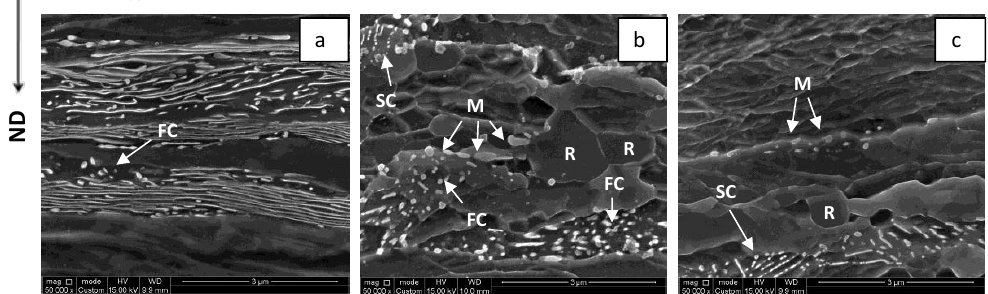
Figure 7. ( a ) SEM image of 70% cold-rolled material; ( b ) SEM of the sample heated at 150 °C/s to 704 °C and quenched and ( c ) SEM sample heated at 1500 °C/s to 749 °C and quenched (etched with 4% Nital). Letters in arrows are FC for fragmented cementite, M for martensite SC for spheroidized cementite, and R for recrystallized ferrite. The scale bar in three micrographs is 3 µm. The advancing of the α/α interface is also hindered by spheroidized cementite particles, as long as the distance between them is small enough to interact effectively with the interface movement [30,31]. Similar pinning effect can be produced by austenite grains (cf. M in Figure 7b,c). Evidence of this is clearly shown in Figures 1a,d and 7b,c. Small particles of cementite are blocking the advance of the recrystallized ferrite into pearlite, thus hindering the process at one side of the recrystallized grains. Otherwise, the recrystallization would progress into both deformed ferrite and pearlite as expected in the absence of growth barriers, such as low-angle grain boundaries with reduced mobility [31]. Instead, it has grown along ferrite bands and has stopped at cementite and pearlite areas. Note in Figure 6 that the boundary between recrystallized ferrite and pearlite has a misorientation angle between 15° and 63°, which predicts a higher mobility than in the case of low-angle grain boundaries [31]. The high-angle grain boundary between recrystallized ferrite and pearlite supports the effect of cementite particles as a barrier for the interface movement. A mixture of recrystallized and non-recrystallized ferritic grains are observed at all temperatures above ~700 °C in samples treated at both heating rates until the formation of 100% austenite. Figure 8 shows the distributions of grain diameters in the recrystallized ferrite for different temperatures at both heating rates. At the beginning of recrystallization, the fraction of grains of diameter less than 1 µm is 53% in samples heated at 150 °C/s, and 99% in samples heated at 1500 °C/s. At later stages, the fraction of grains of diameter less than 1 µm is 14% in samples heated at 150 °C/s, and 66% in samples heated at 1500 °C/s. It can thus be concluded that the nucleation is a continuous process during heating at both heating rates.